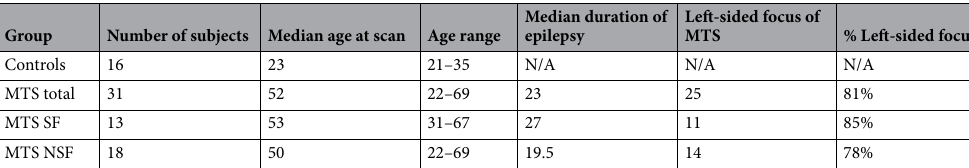
Table 1. Subject